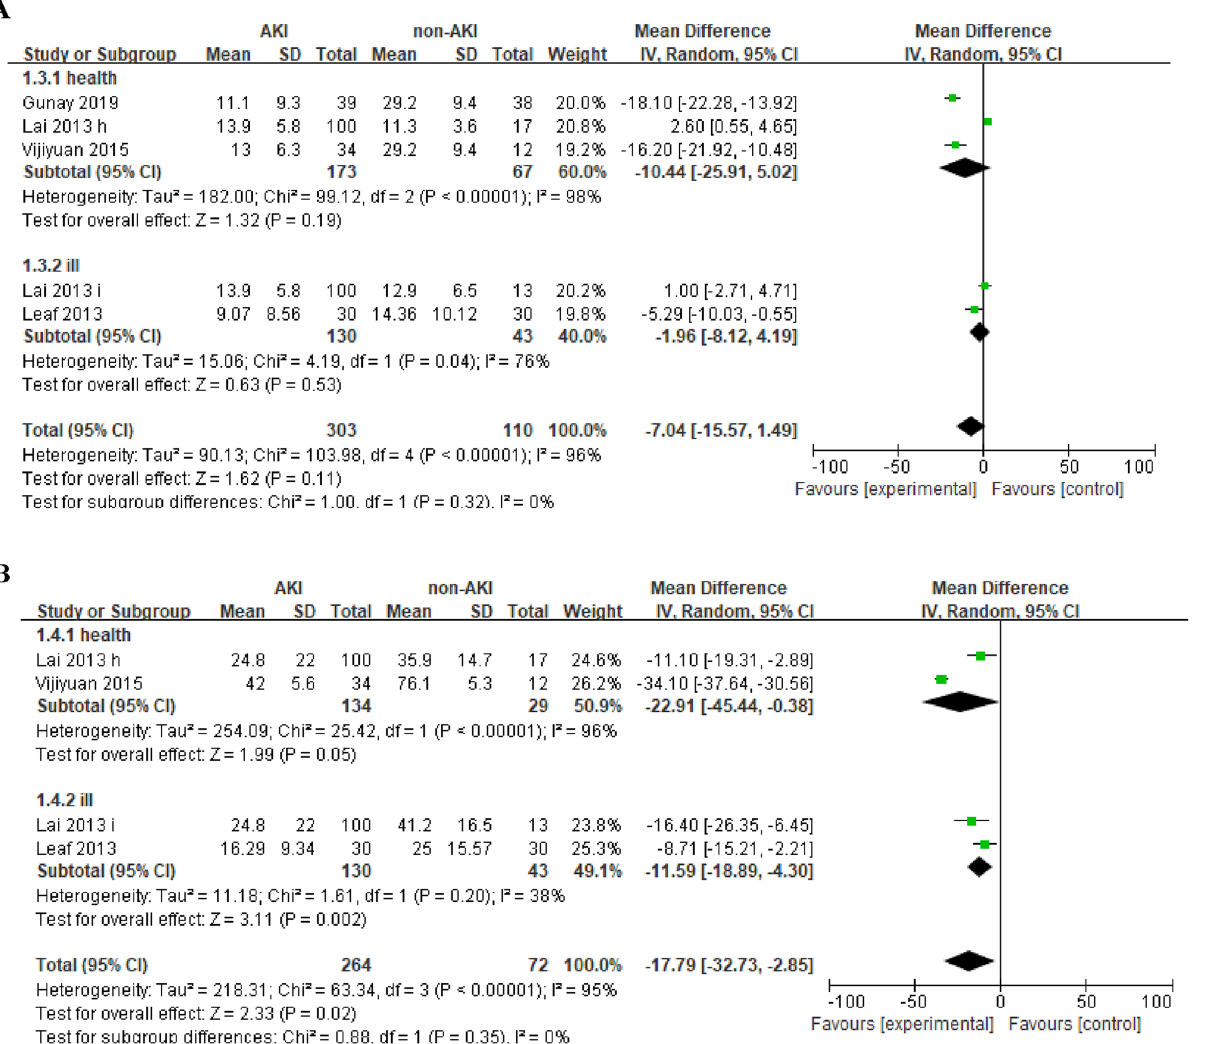
Figure 3. Forest plots of subgroup analysis of the relation between the incidence of AKI and serum Vitamin D in the different contrasts: ( A ) 25(OH)D levels ( B ). 1,25(OH) 2 D levels